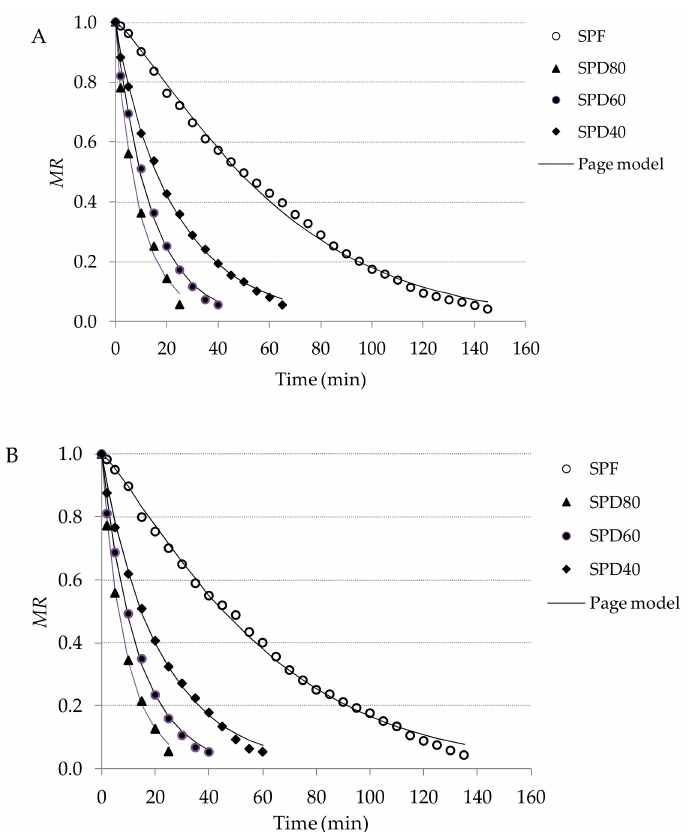
Figure 1. Drying curves of dried broccoli sprouts with experimental and predicted data based on the Page model: MR —moisture ratio, SPD40, SPD60 and SPD80—sprouts air-dried at 40, 60 and 80 ◦ C, respectively, SPF—freeze-dried sprouts, ( A )—after 3 days of germination and ( B )—after 6